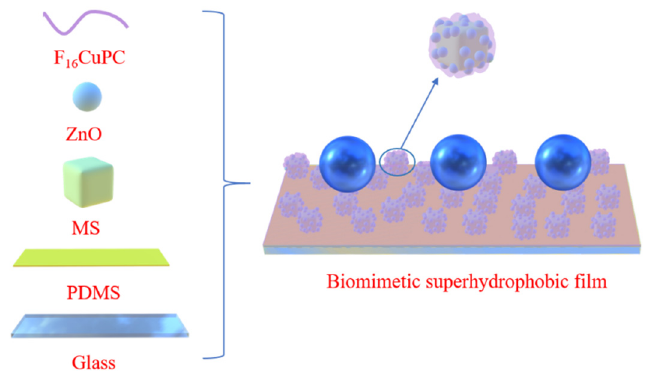
Figure 1. Schematic diagram of the biomimetic superhydrophobic film.